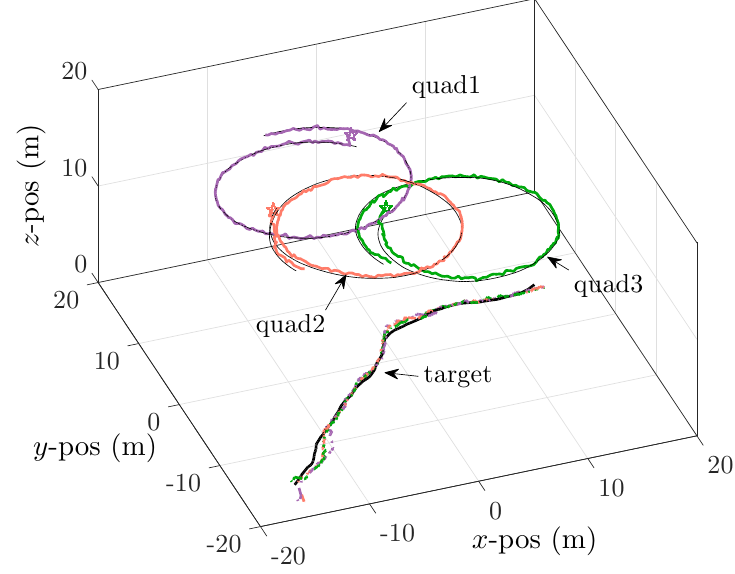
Figure 11. Trajectories of three quadrotors’ self-localization results and target tracking results with different colors. Ground truth is indicated by black